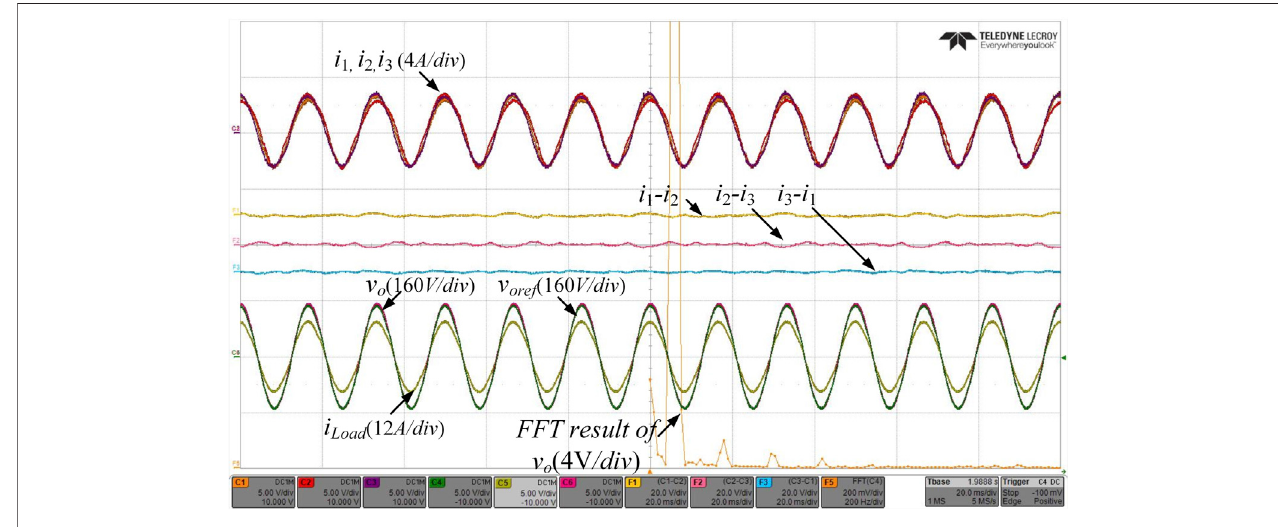
FIGURE 14 | Linear load under balanced condition.